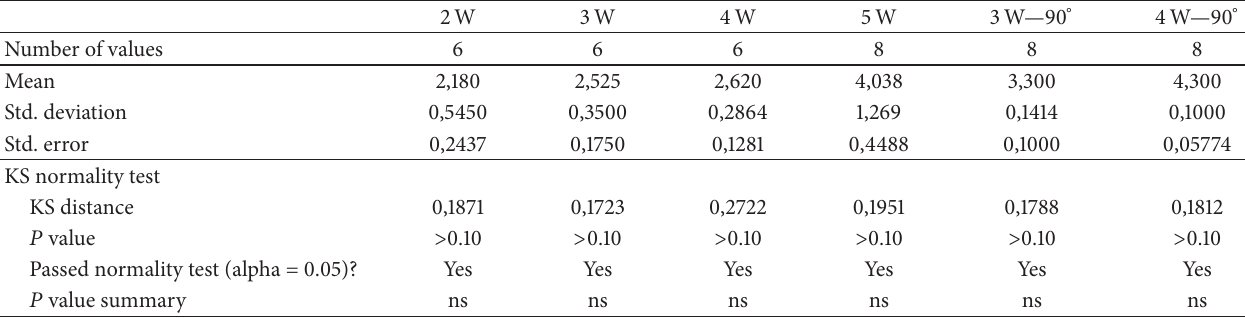
Table 1: Means and standard deviations for each irradiation condition. All groups passed the normality test of Kolmogorov-Smirnov test (with Dallal-Wilkinson-Lillie for 𝑃